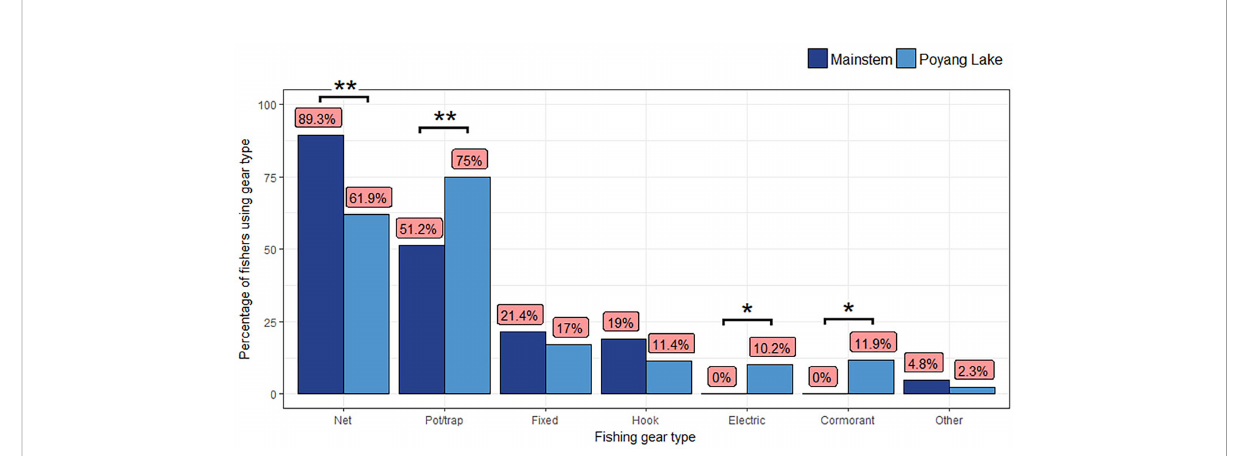
FIGURE 6 Differences in functional fi shing gear use by fi shers in Yangtze mainstem and Poyang Lake. Asterisks indicate signi fi cant differences between regions at the 5% level (*) and 1% level